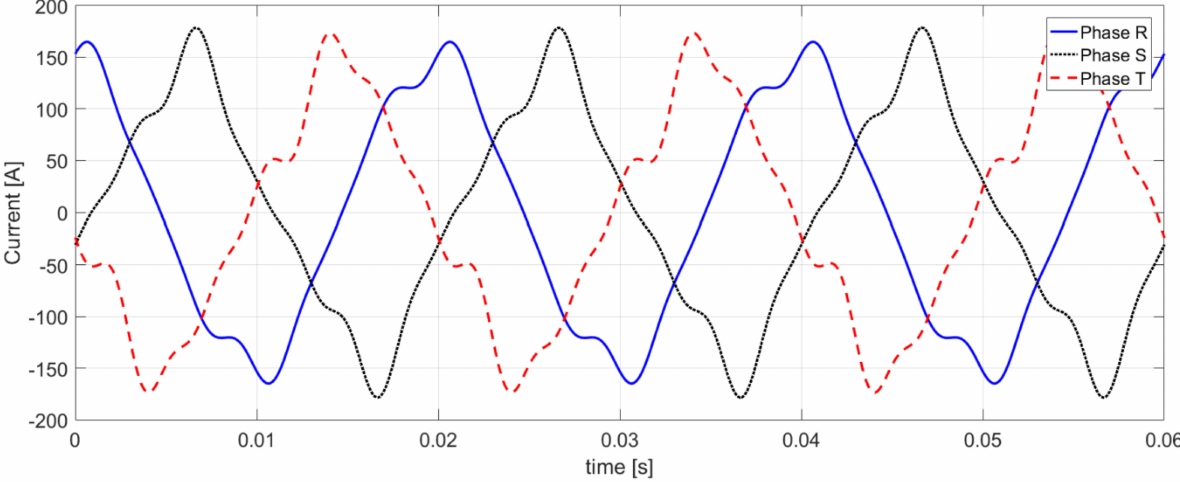
Figure 6. The three-phase current waveforms of the load after minimizing balancing compensation. Due to the use of the minimizing balancing compensation, the power factor λ (22) increased to the value of